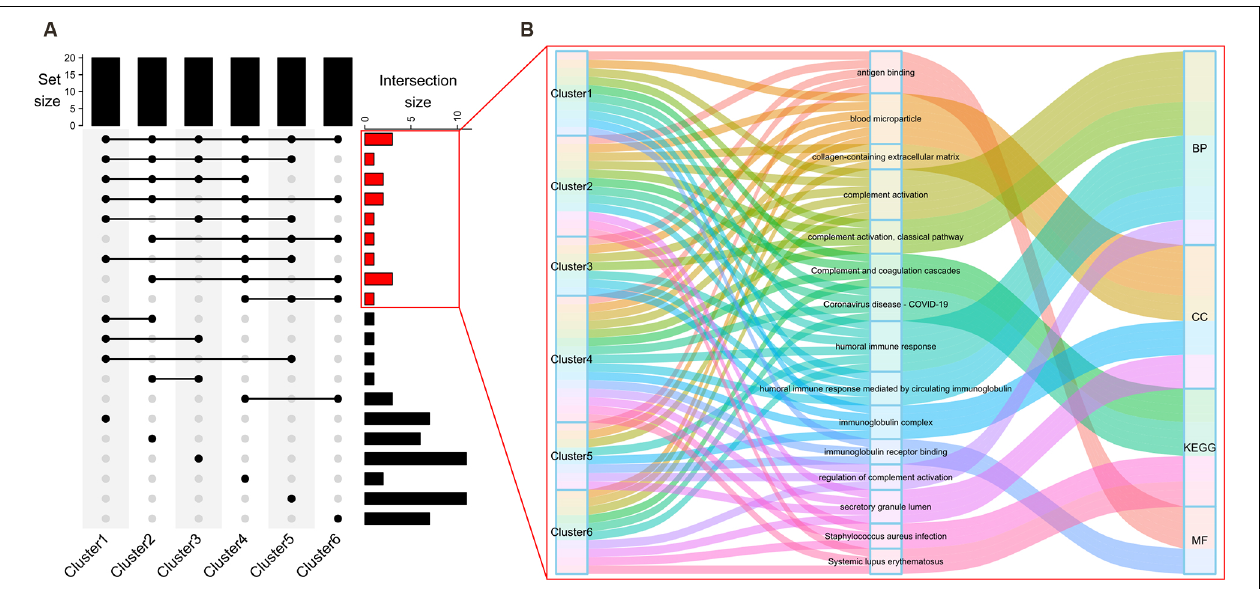
FIGURE 4 | Discovery of core pathways for cognitive decline. The top histogram of the upset plot (A) shows the set size of each cluster (five top enriched KEGG pathways plus 5*3 top enriched GO terms under BP, CC, or MF branches, a total of 20 pathways/GO terms). The right histogram represents the size of intersection between two, or among more than two clusters. Specifically, right histograms correspond to the pathways/GO terms co-regulated by the majority ( ≥ 3) of clusters were marked in red. Details within these histograms are further depicted in a Sankey diagram (B) . Each flow is colored to represent a specific KEGG pathway/GO term. The information flow starts from blocks representing different clusters (source node), passes through the second column of blocks representing the biological processes, and finally converges on one of the four (BP, CC, MF, KEGG) ontologies (sink node).